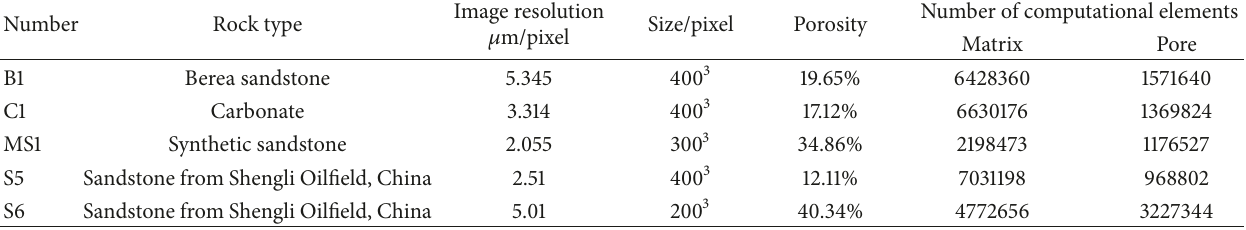
Table 1: Rock sample image information.